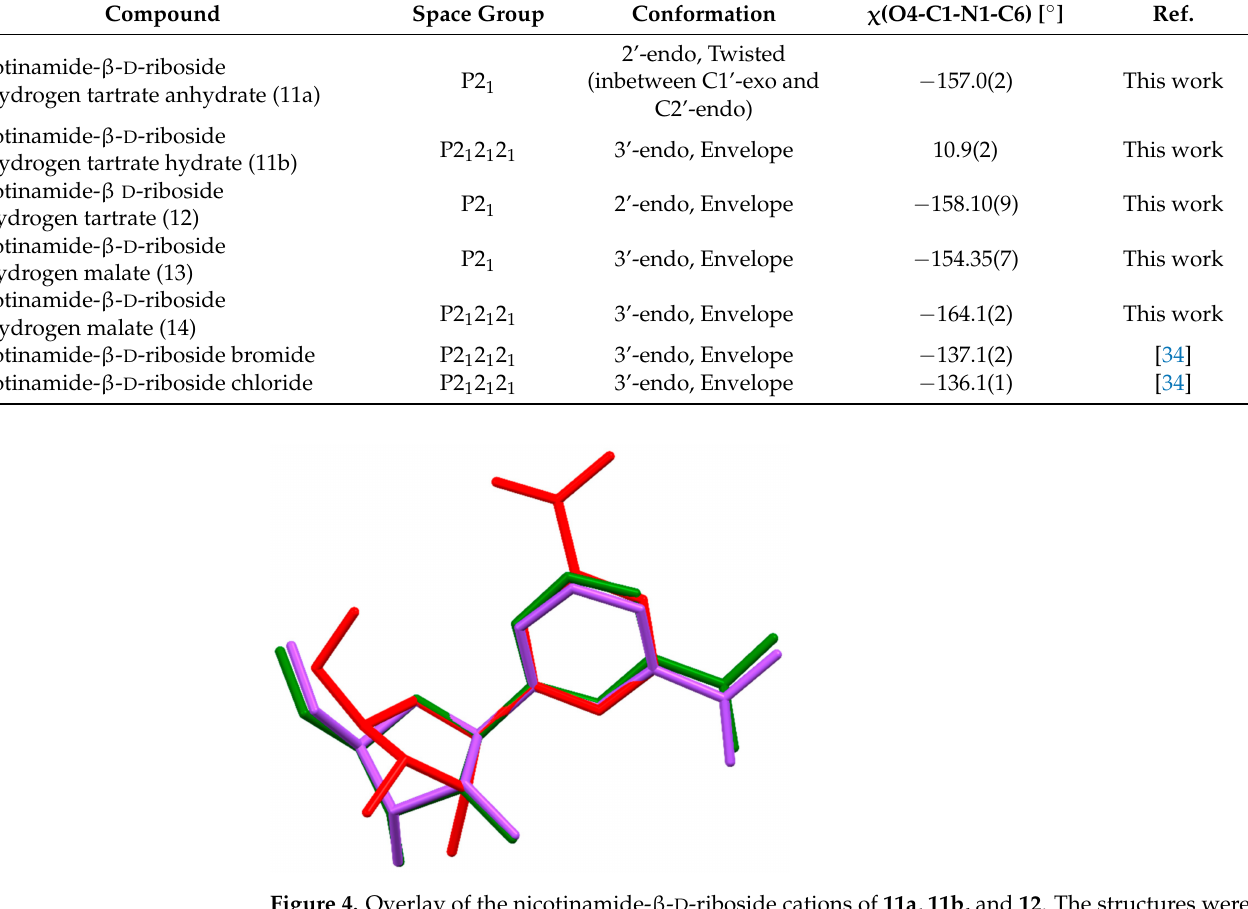
Figure 4. Overlay of the nicotinamide- β - D -riboside cations of 11a , 11b, and 12 . The structures were overlayed on atoms O4, C1, and N1 with the help of the program Mercury.